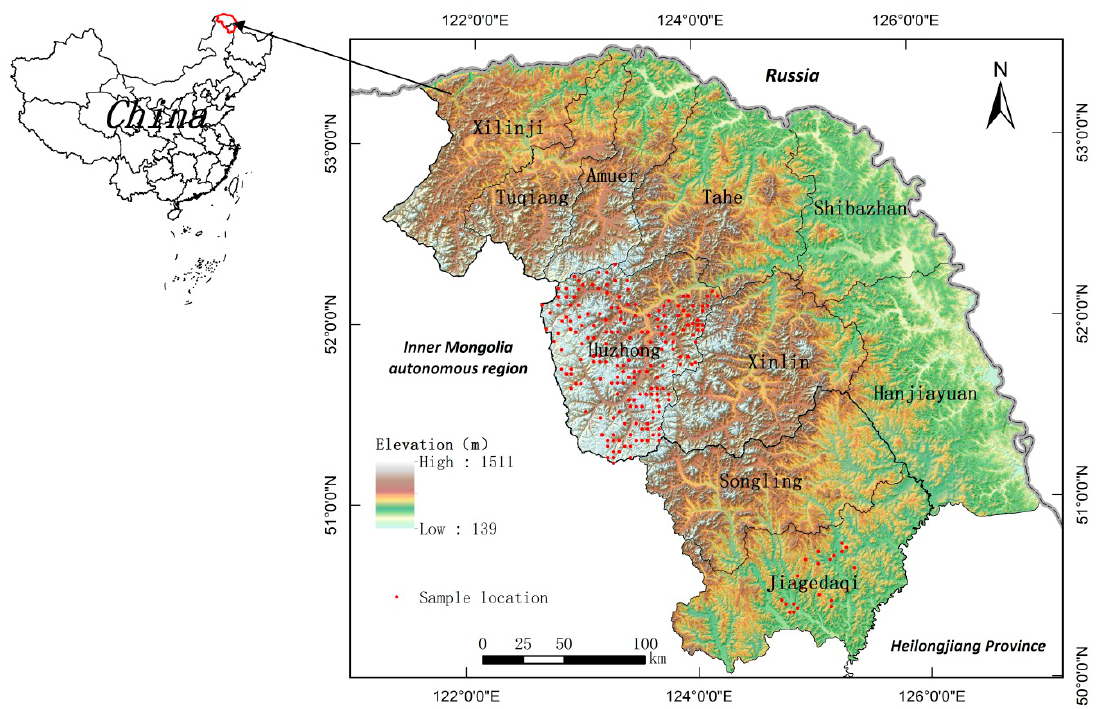
Figure 1. The location and elevation of the study area with the distribution of the forest inventory plots (red